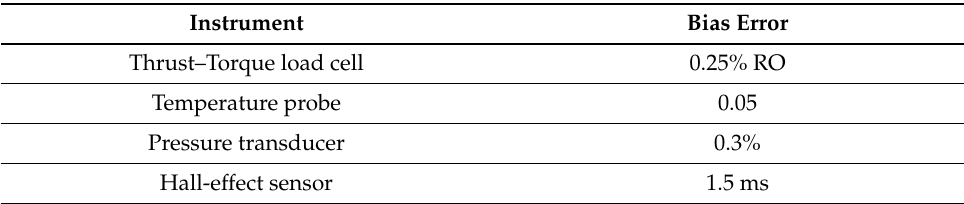
Table 4. Instrumentation error